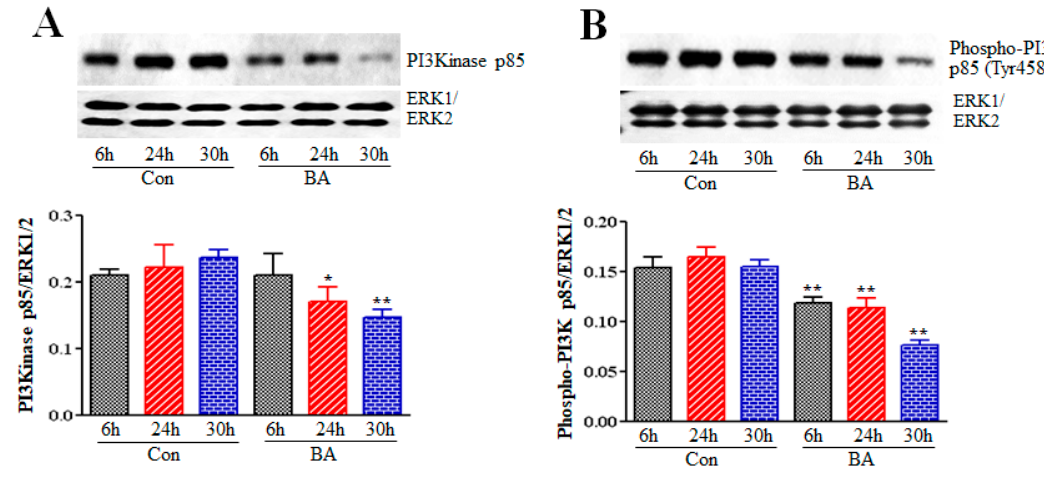
Figure 2. E ff ect of butyrate (BA) on PI3K in VSMCs. Proliferating VSMCs were treated with or without 5 mM butyrate for indicated periods of time. At the end of treatment, cell lysates were prepared and subjected to Western blot analysis to determine the PI3K expression and activation level by measuring the level of unphosphorylated and phosphorylated p85 subunit of PI3K, respectively. Immunoblotting of ERK1 / 2 was performed with the same lysate to normalize the protein loading. The band intensities were measured and normalized to protein loading. The data obtained were analyzed and presented as mean ± S.D. ( A ) Expression level of PI3K p85 subunit measured by using antibody specific to p85 subunit (* p < 0.01 vs 24 h control (Con), and ** p < 0.001 vs 30 h control (Con). ( B ) Activation of p85 subunit of PI3K was evaluated by the antibody specific to Tyr458-phosphorylated p85 (** p < 0.001 vs respective control (Con).